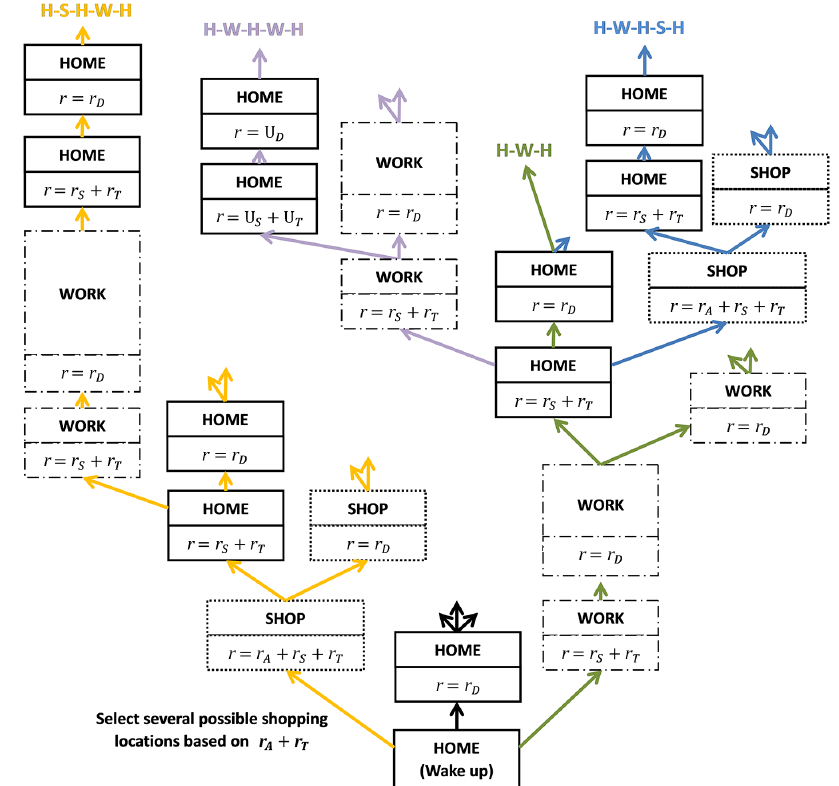
Fig. 3. Q-learning flow